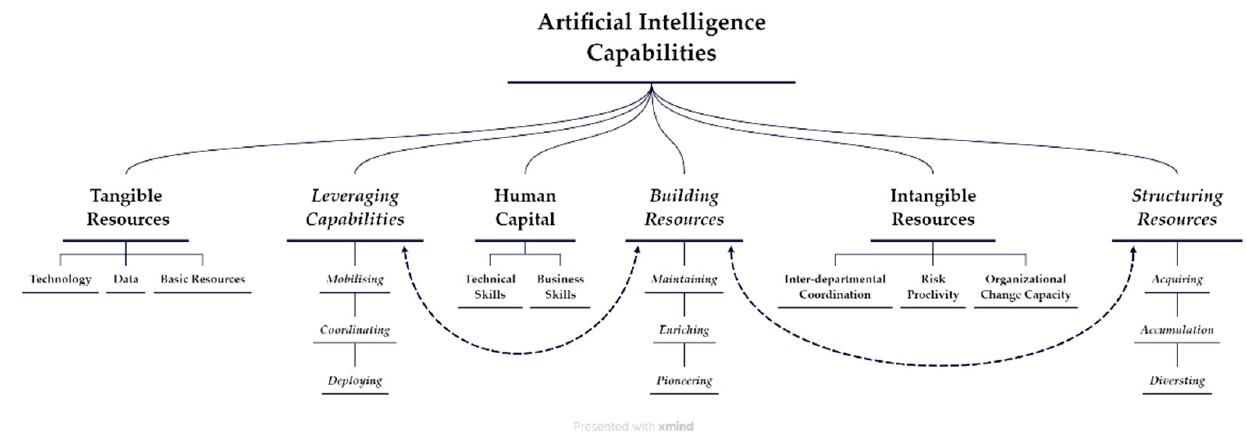
Figure 3. Categorization of resources to ideation and implementation of AI capabilities Source: Own elaboration.